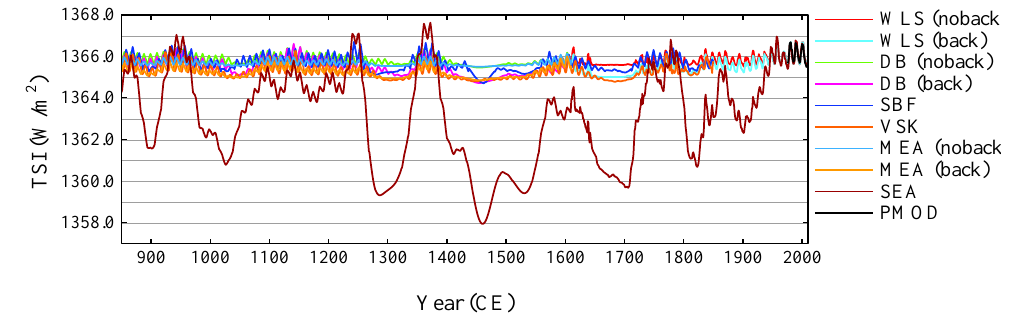
Fig. 2. Estimates of TSI including the SEA reconstruction calibrated to the WLS reconstructions over 1976–2006. Note: DB = Delaygue and Bard (2011), MEA = Muscheler et al. (2007), PMOD = Fr¨ohlich (2009), SBF = Steinhilber et al. (2009), SEA = Shapiro et al. (2011), VSK = Vieira et al. (2011), WLS = Wang et al. (2005).